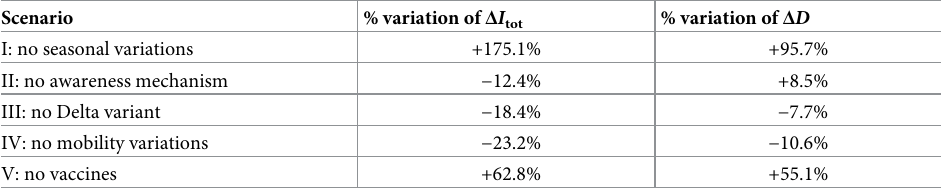
Table 6. Percentage variations in the number of total infected detected cases and total deaths with respect to the reference simulation at the final day of simulation (December 16, 2021).